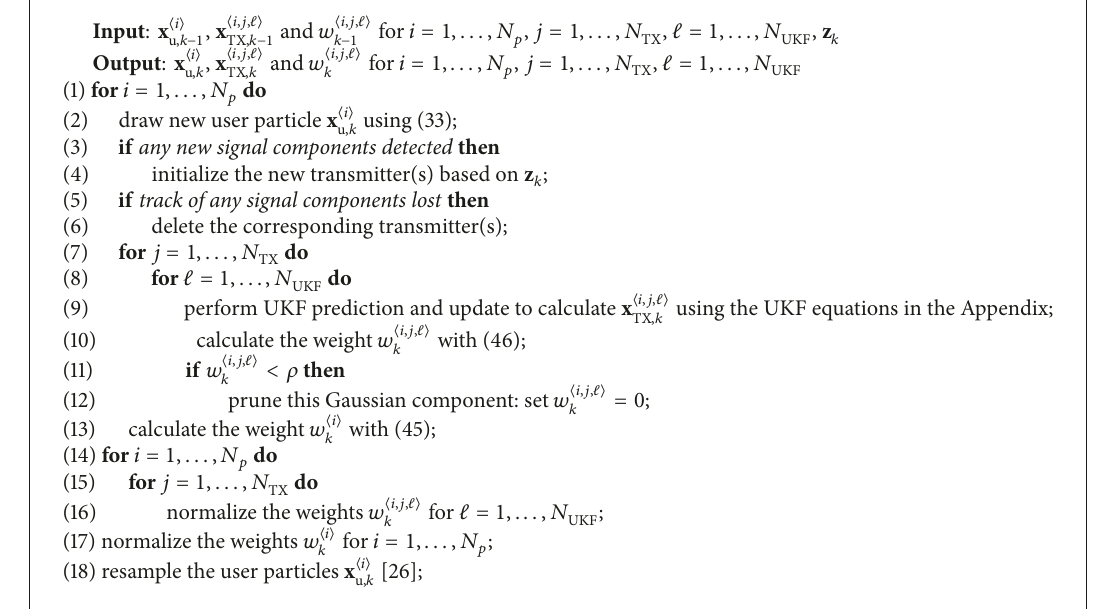
Algorithm 1: RBGSPF for time instant 𝑘 > 0 .